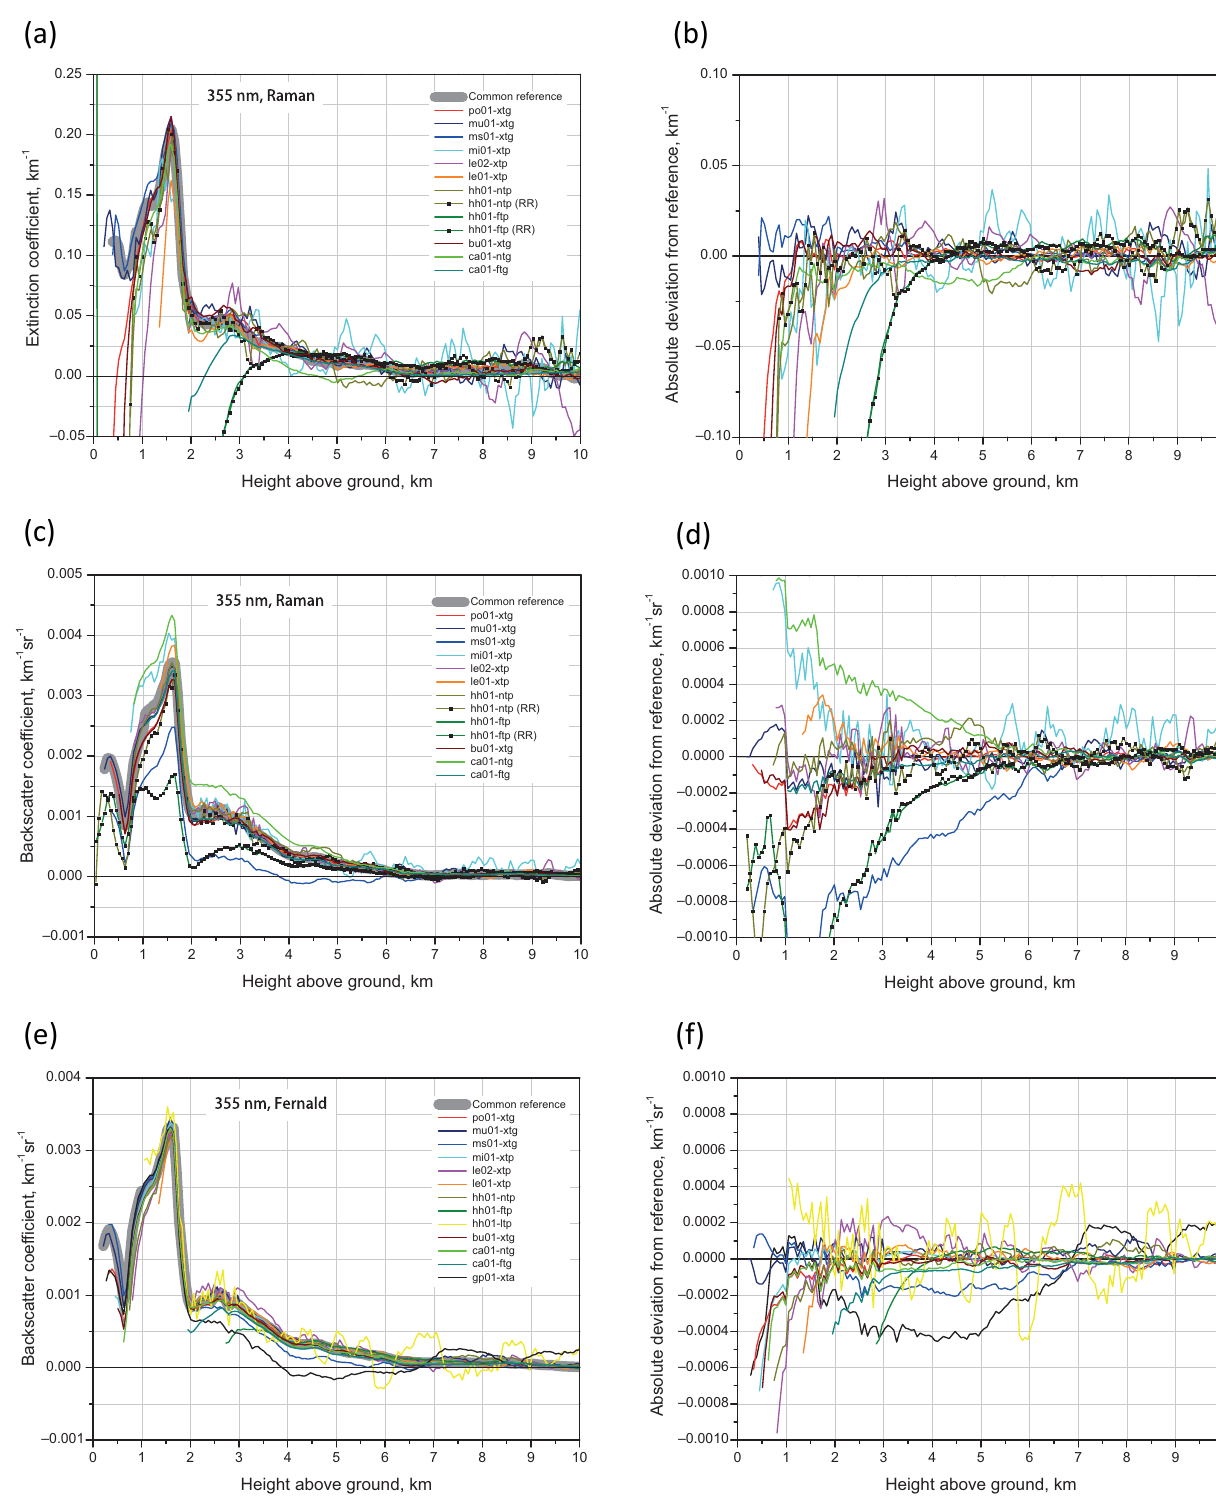
Figure 5. Comparison of particle extinction coefficients (a) and particle backscatter coefficients derived using the Raman (c) and Fernald methods (e) , respectively, at 355nm and their absolute deviations from the common reference (b, d, e) . The measurement was performed during EARLI09 on 25 May 2009,